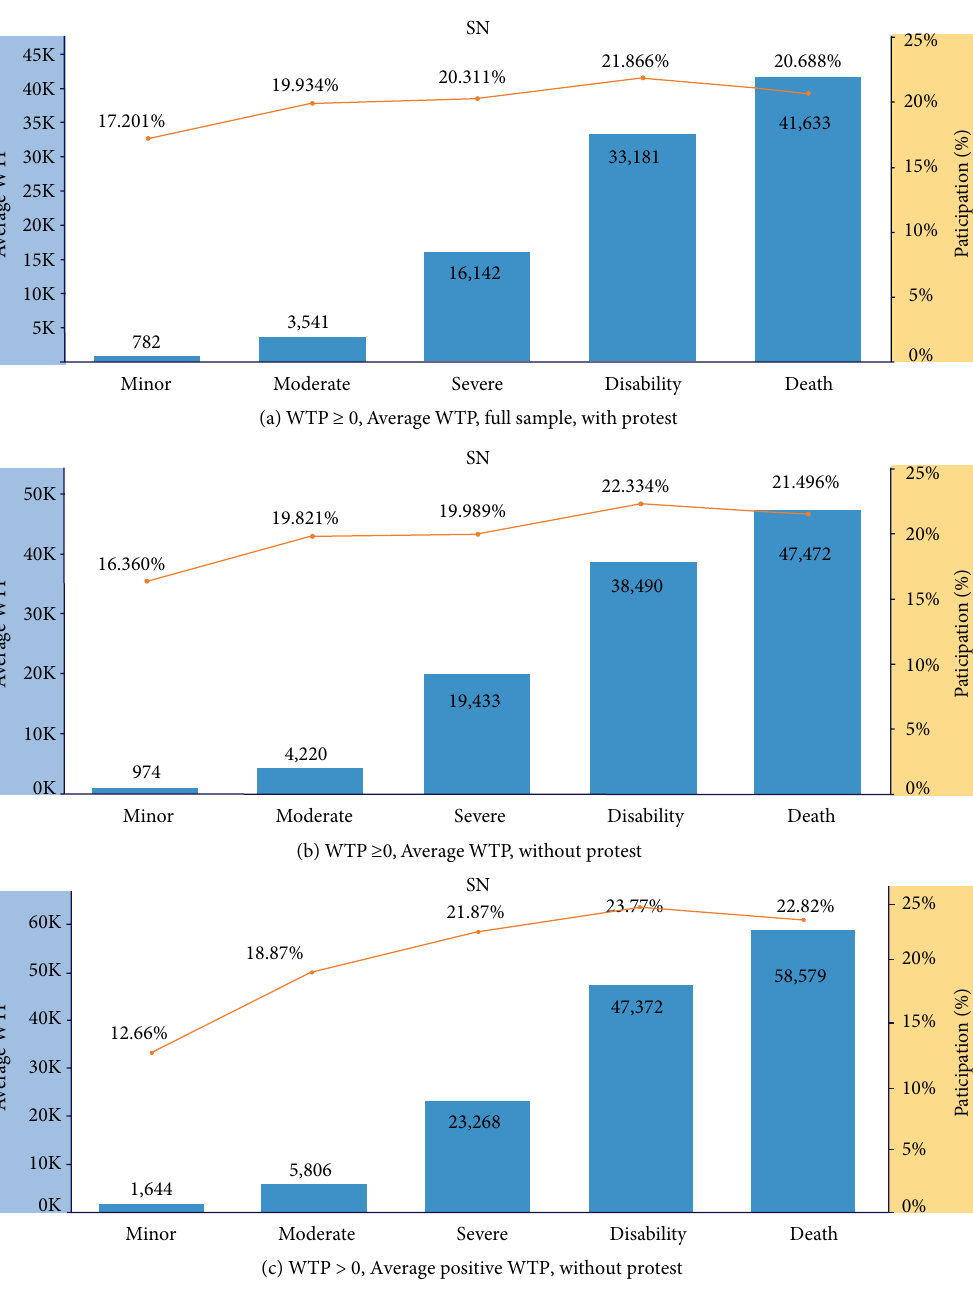
Figure 4: Participation rates and average WTP by injury severity. Note: WTP stands for willingness to